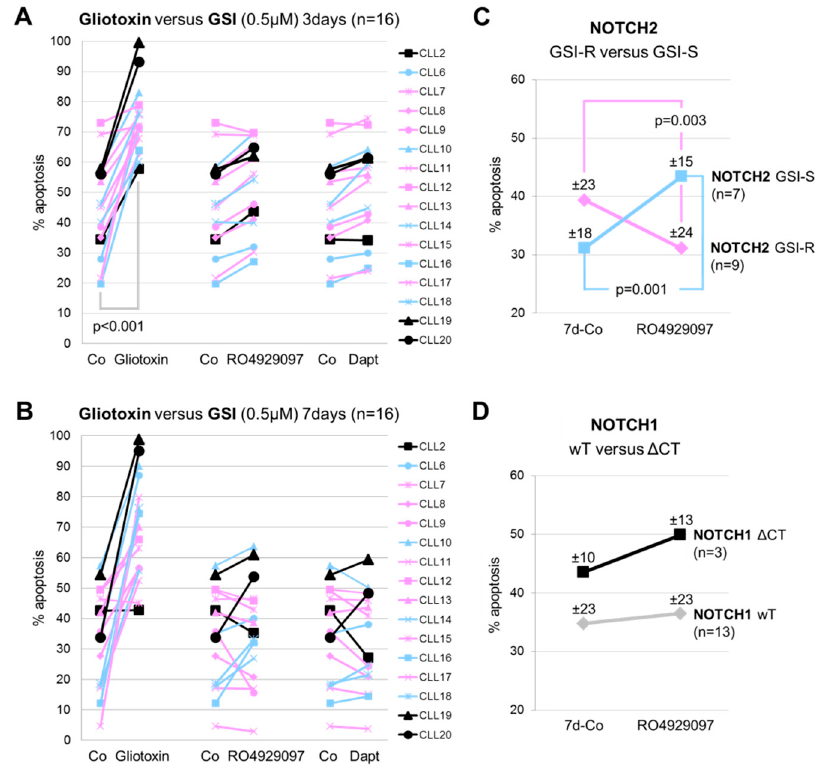
Figure 2. E ff ect of gliotoxin, RO4929097, and DAPT on apoptosis in CLL cells. Sixteen CLL cases, including 3 cases with the recurrent NOTCH1 ∆ CT mutation (black lines), 8 cases expressing GSI-R nuclear NOTCH2 (pink lines), and 5 cases expressing GSI-S nuclear NOTCH2 (blue lines), were subjected to FACS analysis and the induction / inhibition of apoptosis in response to the indicated drug concentrations relative to controls was determined after 3 ( A ) and 7 days ( B ) in suspension cultures. The mean e ff ects ( ± SD) of 0.5 µ M RO4929097 on the percentage of apoptotic CLL cells after 7 days in relation to the GSI sensitivity of NOTCH2 ( C ) and the NOTCH1 mutational status ( D ) are indicated.